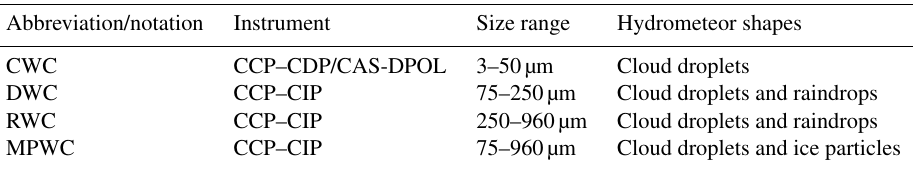
Table 2. Description of cloud probes, size range intervals, and hydrometeor shapes observed on CCP–CIP images used to calculate CWC, DWC, RWC, and